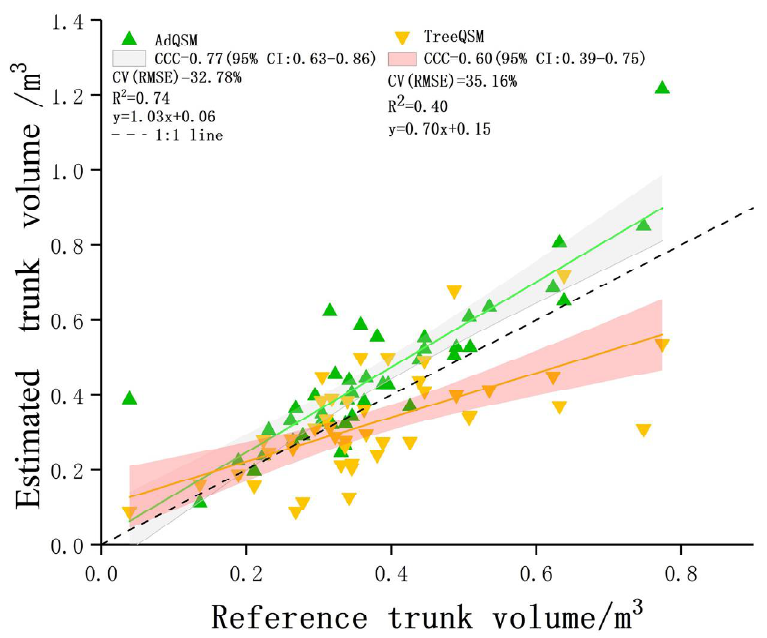
Figure 15. The trunk volume of trees estimated by two QSM methods was compared with the reference measurements. The green line represents fitted linear regression model between estimation of AdQSM and reference values, and the orange line represents fitted linear regression model between estimation of TreeQSM and reference values. The gray band represents 95% confidence interval for AdQSM regression. The orange band represents 95% confidence interval for TreeQSM regression.